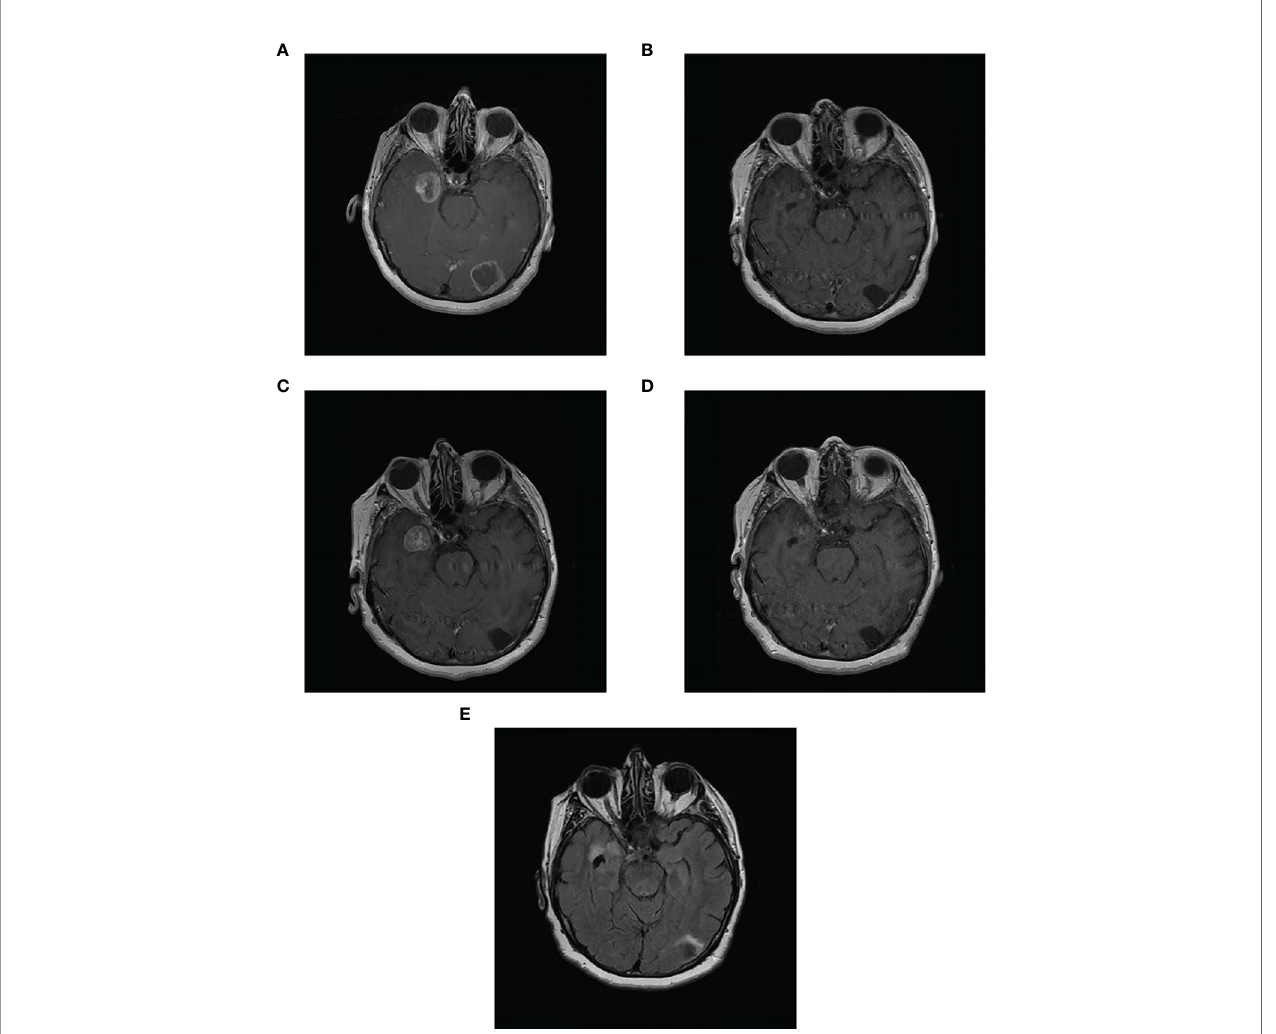
FIGURE 2 | Complete response of 2 asymptomatic brain metastases in patient case 3. Magnetic resonance imaging scans of patient case 3: (A) with 2 brain metastases in the left occipital lobe and right temporal lobe prior to starting avelumab (May 9, 2018); (B) Complete response in occipital lobe and partial response in temporal lobe metastases after 8 months of avelumab (January 21, 2019); (C) PD in temporal lobe metastasis after 10 months of avelumab (April 29, 2019; patient began concurrent SRS on May 31, 2019); (D) substantial decrease in size of temporal lobe metastasis after SRS and 15 months of avelumab (September 4,